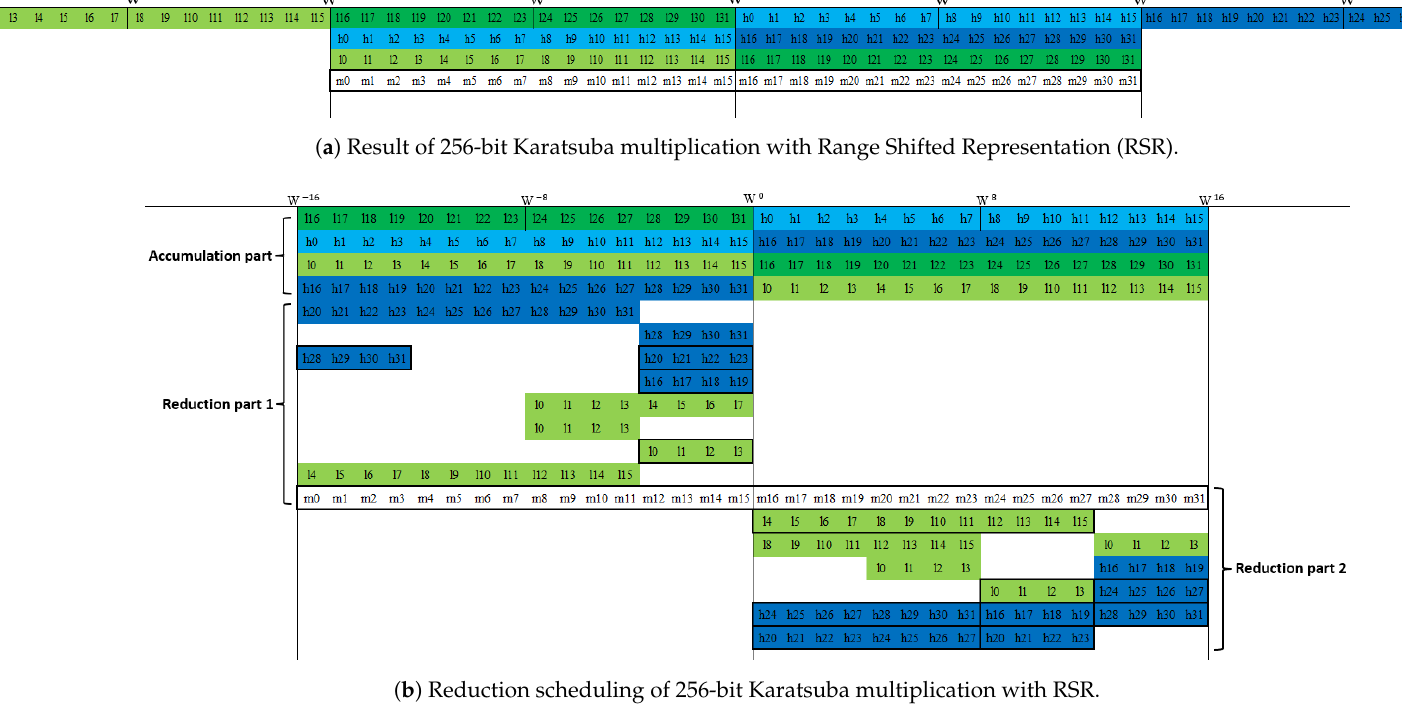
Figure 1. Process of 256-bit Modular multiplication with